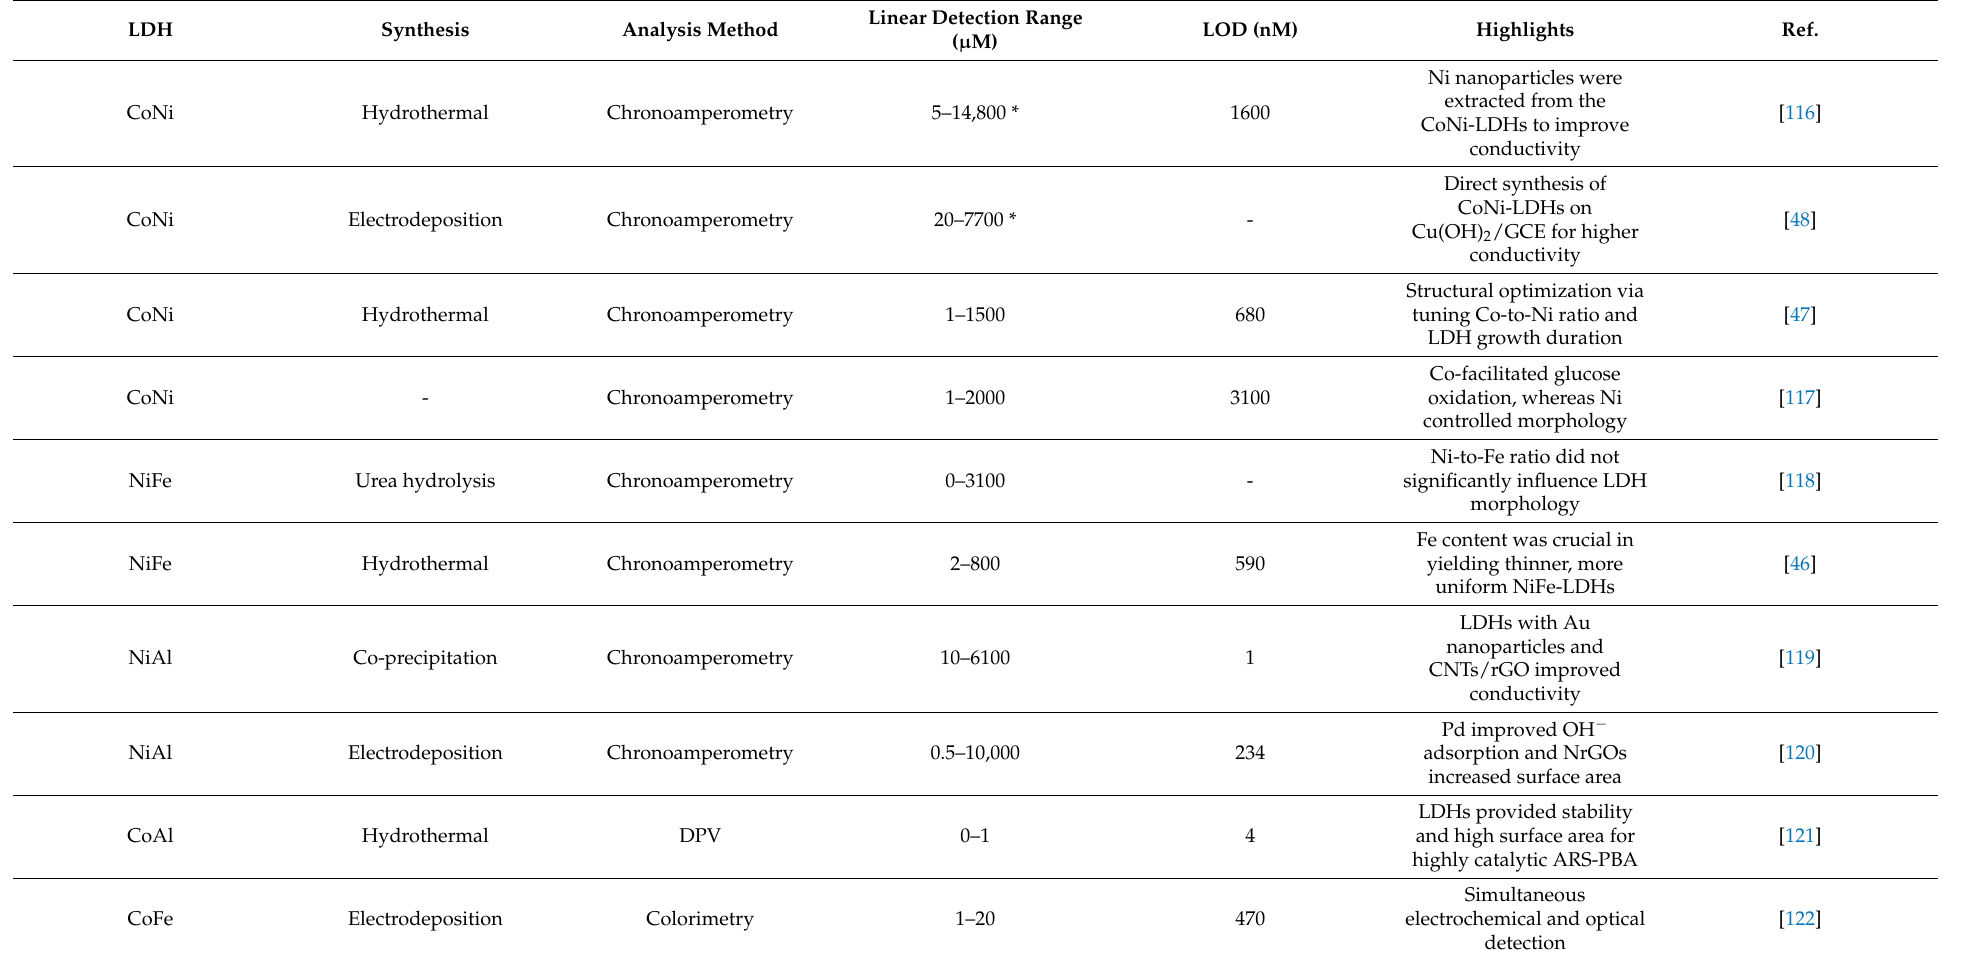
Table 1. The detection performance of LDH-based glucose